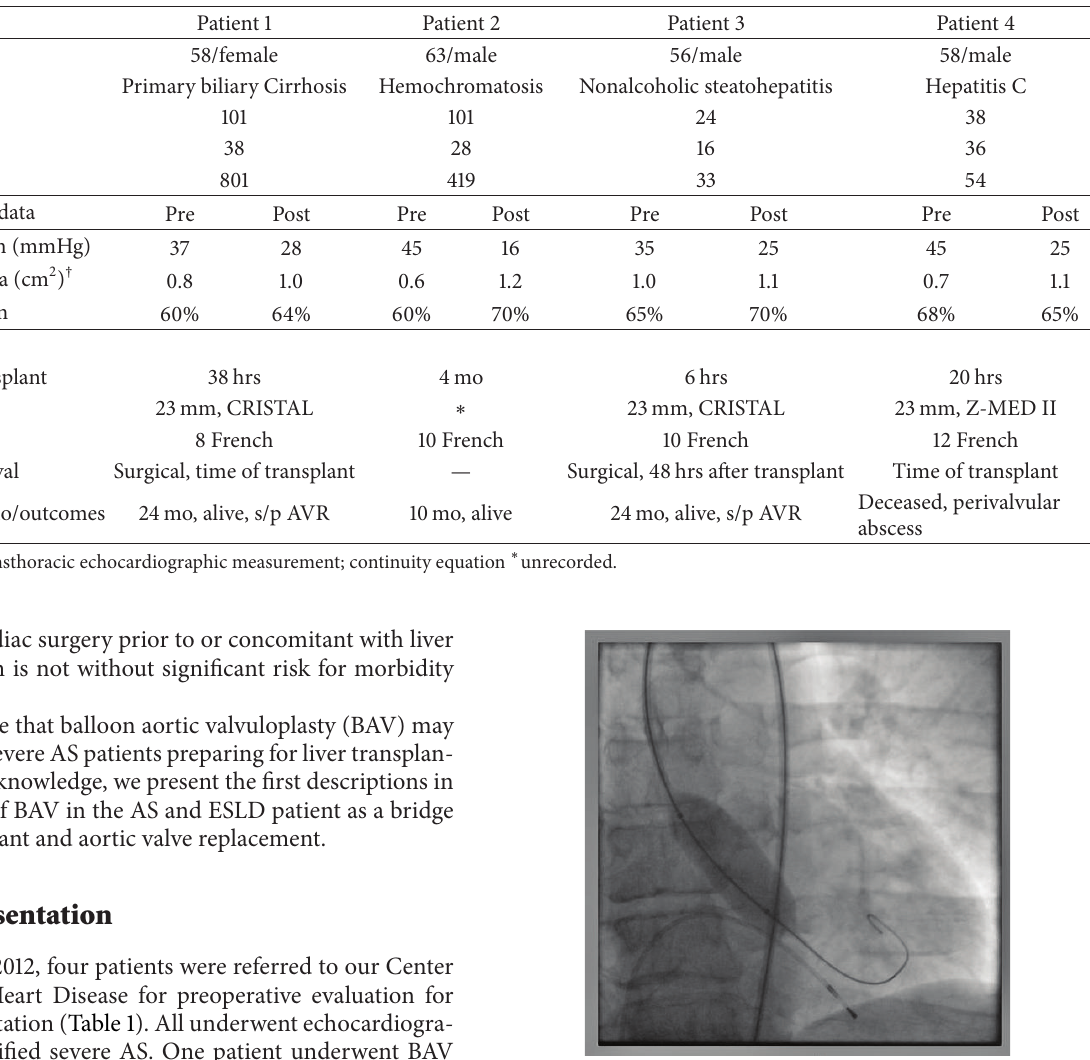
Figure 1: Balloon aortic valvuloplasty is performed under rapid ventricular pacing prior to liver